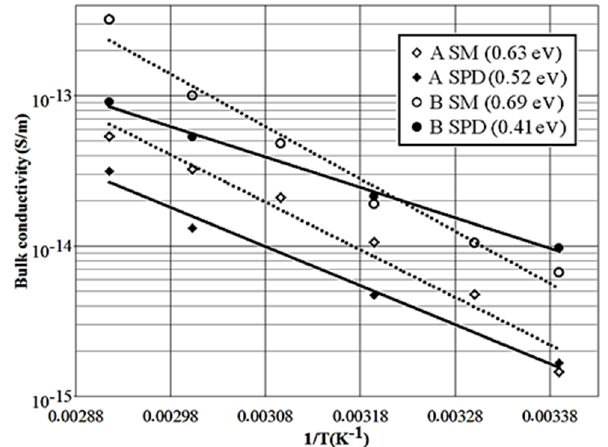
Figure 6. Bulk conductivities as functions of reciprocal of absolute temperature for pure and ATH filled materials (indicated as A and B in the legend). The slopes of the lines corresponding to activation energies are given in the brackets in the legends.